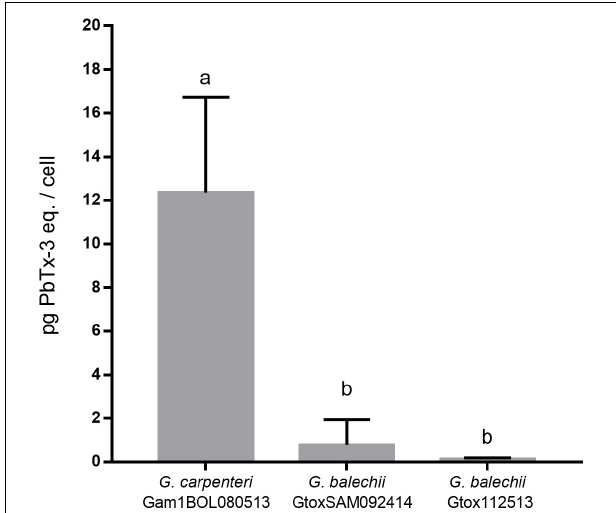
FIGURE 4 | Toxin content of crude acetone extracts of G. carpenteri Gam1BOL080513, G. balechii GtoxSAM092414, and G. balechii Gtox112513 shown in pg PbTx-3 eq./cell. The two G. balechii strains had ∼ 15 to ∼ 91-fold lower toxin content compared to G. carpenteri . Results are presented mean + SD ( n = 3). Different letters indicate significant difference after one-way ANOVA analysis ( P < 0.05).